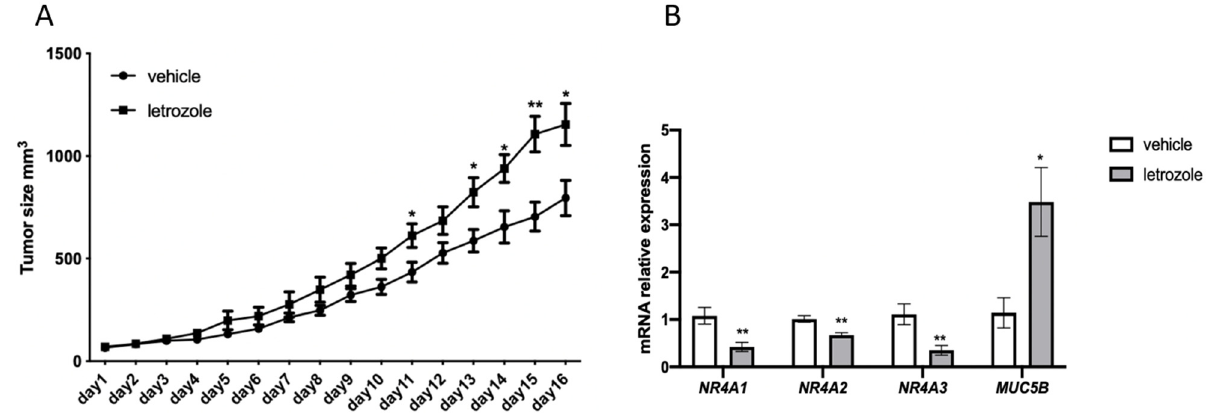
Figure 7. Inhibition of estrogen synthesis by the aromatase inhibitor letrozole stimulates the growth of U2932 tumors and affects the expression of NR4A and MUC5B . ( A ), Male NSG mice were injected subcutaneously with U2932 cells and treated subcutaneously daily with vehicle or the aromatase inhibitor letrozole (10 μ g/mouse). The vehicle group consisted of 7 mice, letrozole group consisted of 8 mice. Tumor size was measured daily. ( B ), RT-qPCR analysis of NR4A1 , NR4A2 , NR4A3 and MUC5B . Results are presented as relative expressions (mean ± SD). An unpaired two-tailed t-test was used for statistical analysis between the two groups (* p < 0.05, ** p < 0.01).